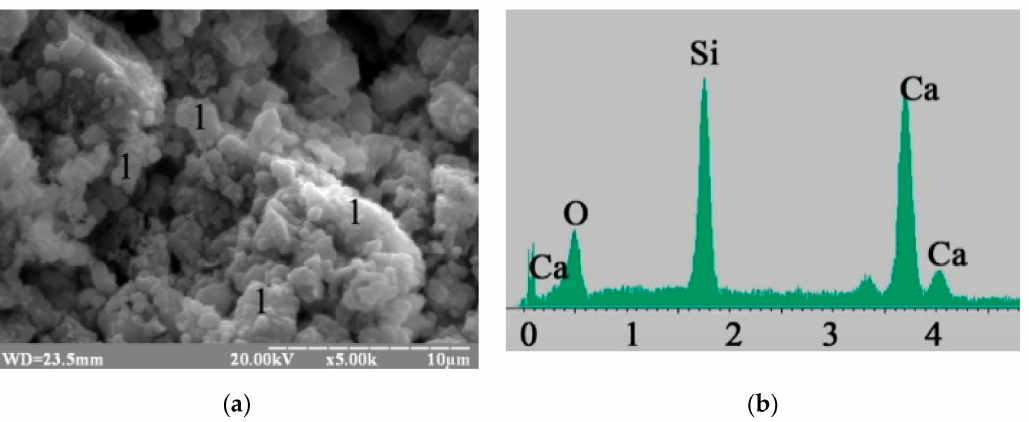
Figure 8. Microstructure of the 180-day hydrated blast furnace cement mixed with sea water and containing Na 2 SiO 3 · 5H 2 O: ( a ) SEM image; ( b ) Microprobe analysis in point